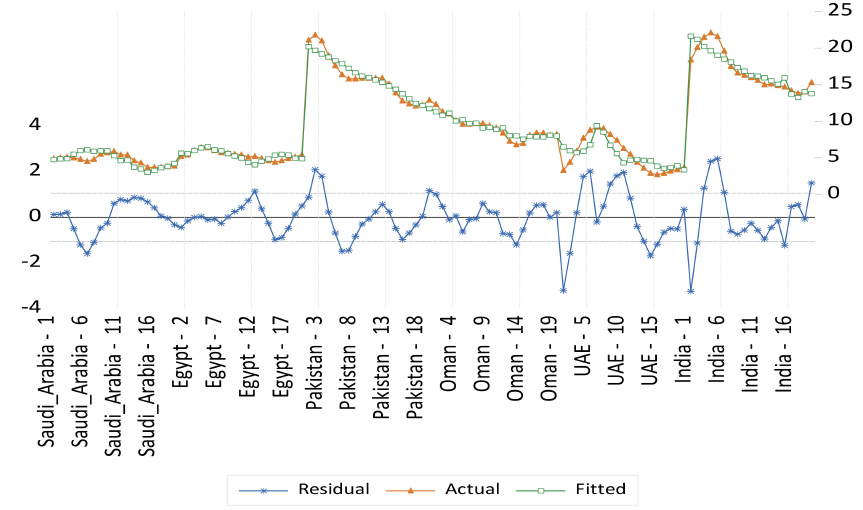
Figure 4. Actual, fitted, and residual of the undernourishment fixed-effects model.